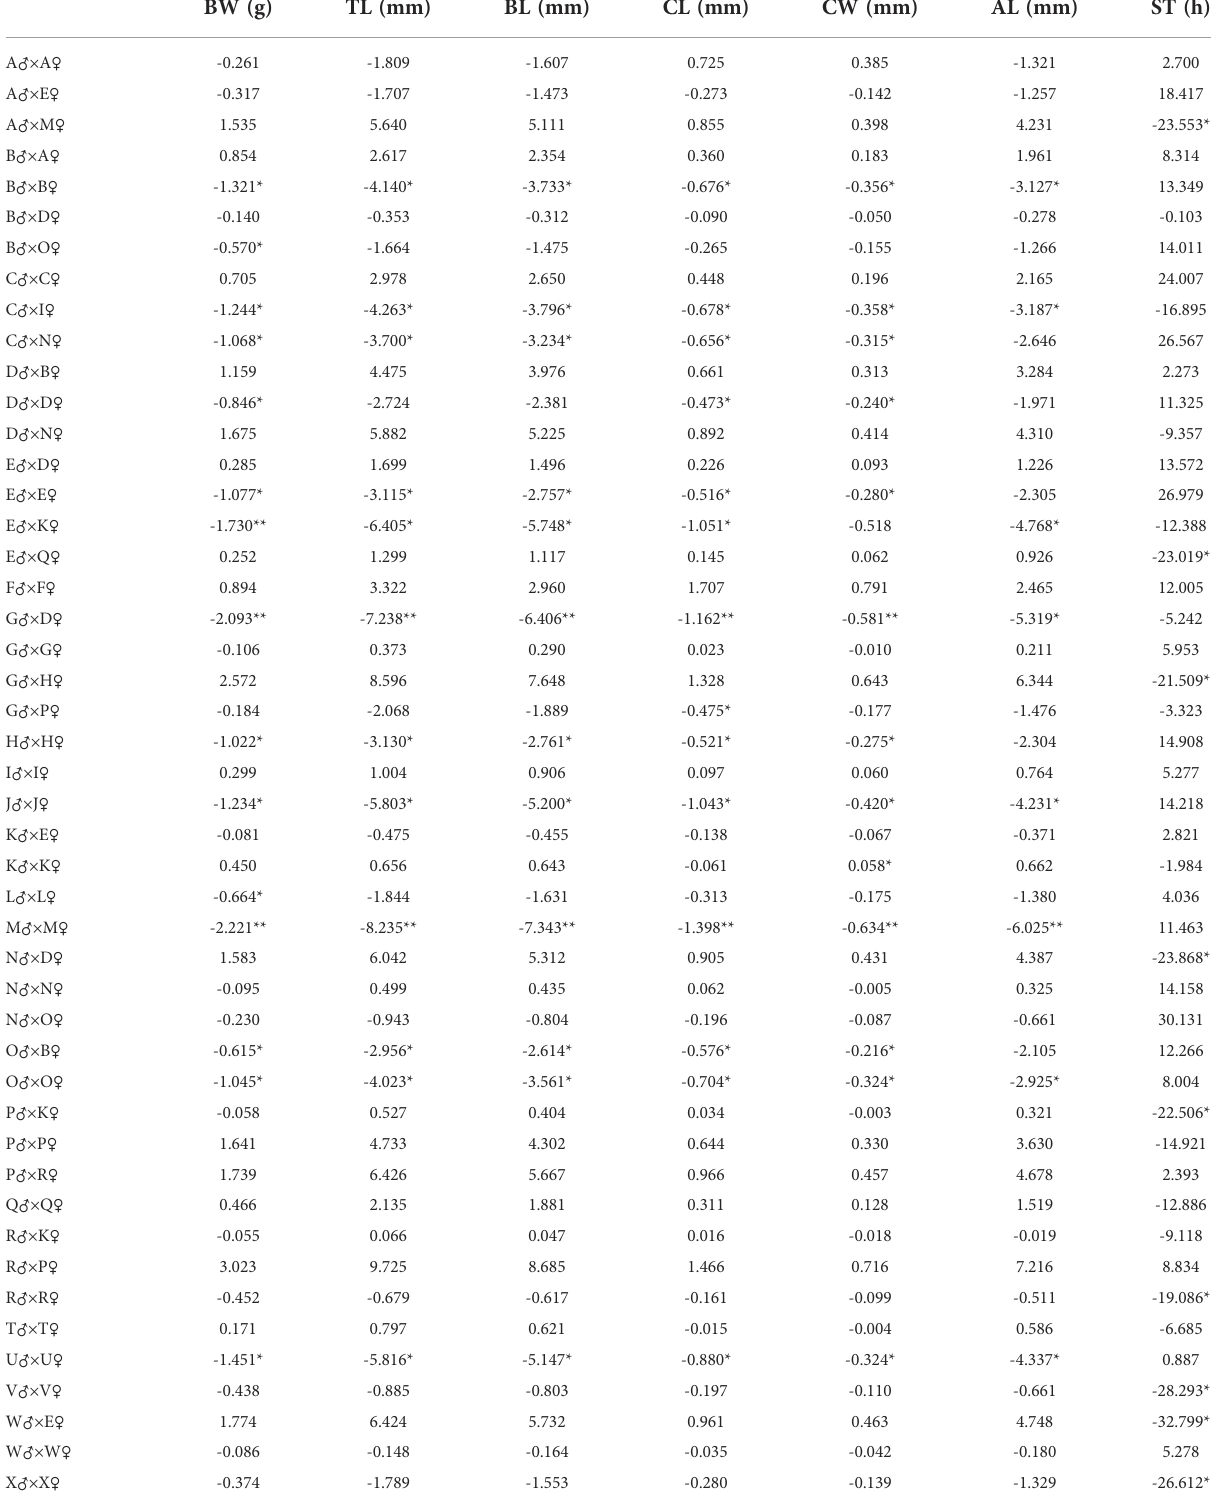
TABLE 3 SCAs for 47 combinations of L. vannamei at 15 week old.